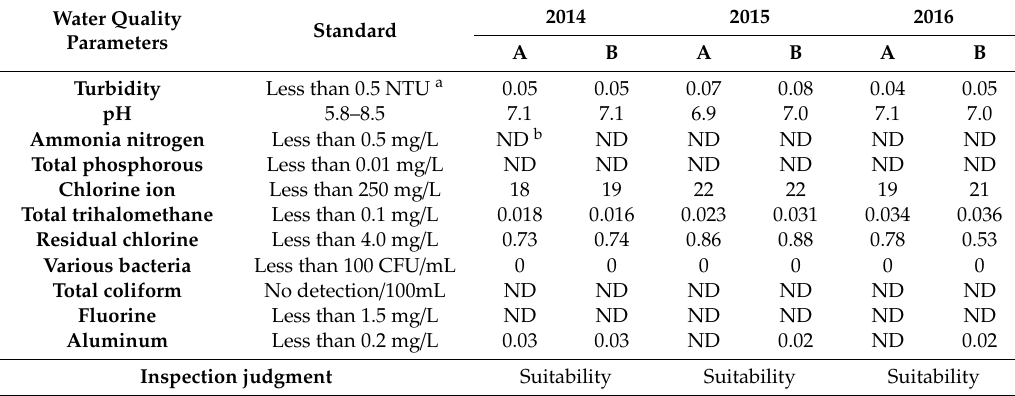
Table 5. Comparison of average water quality of treated water from Plants A and